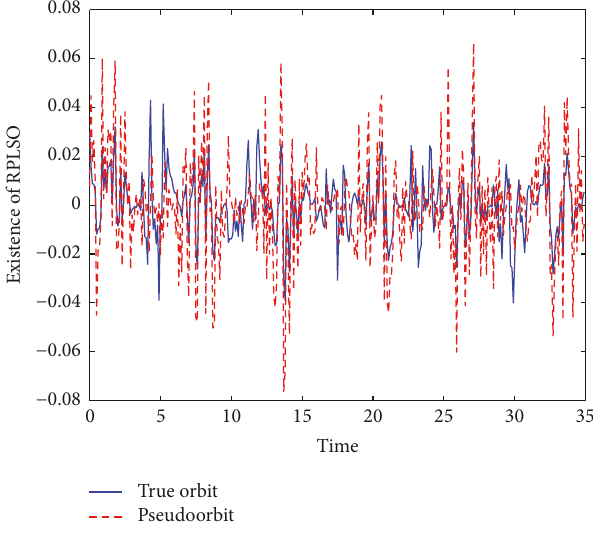
Figure 2: Existence of